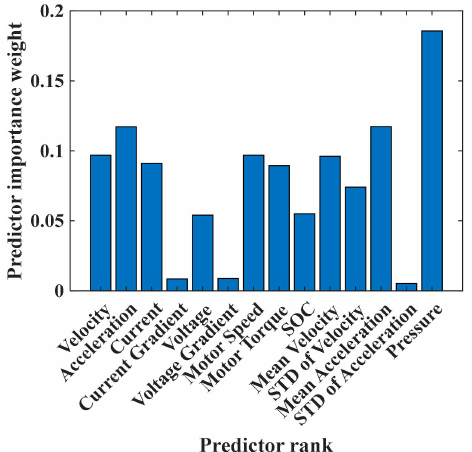
Figure 6. Rank importance of each predictor during brake intention prediction using